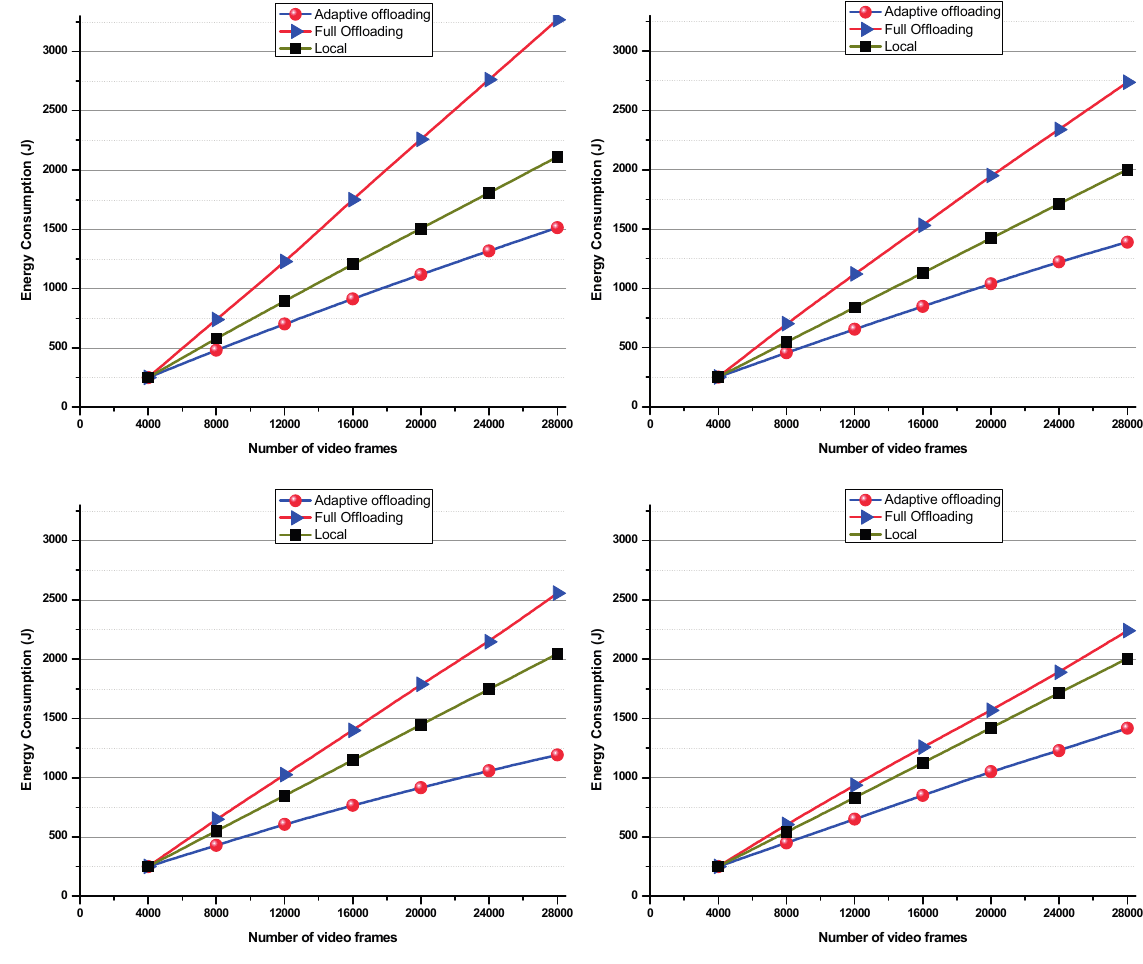
Figure 9. Graph describing in detail the effect of three computational scenarios: (1) local processing ; (2) full-offloading ; and (3) adaptive-offloading method on energy consumption in generating video